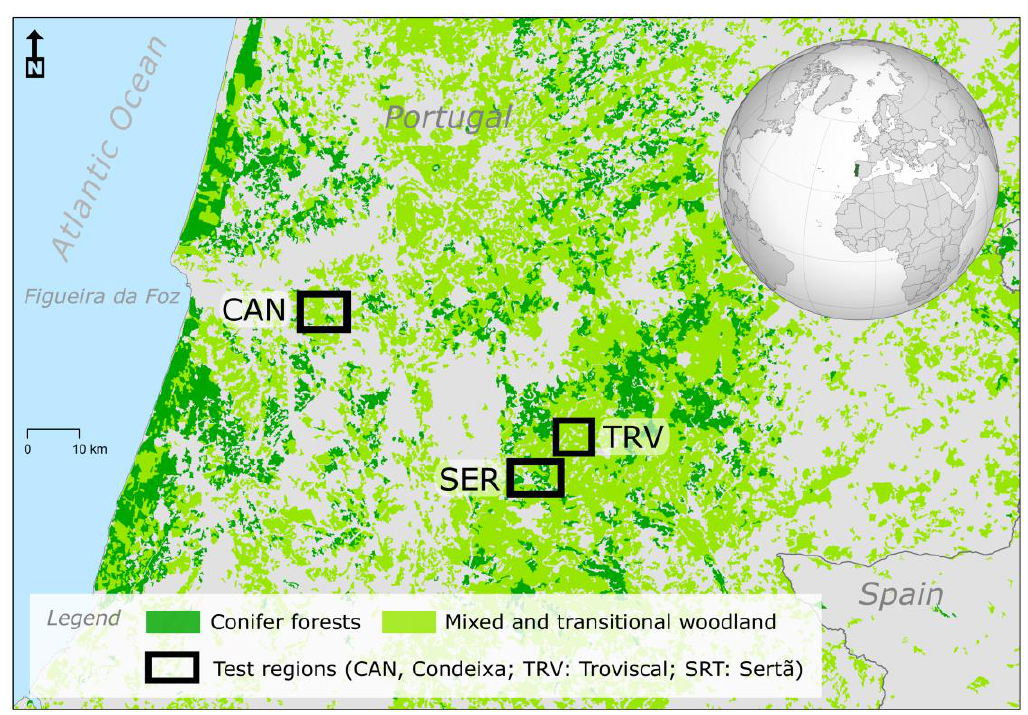
Figure 1. Location of the test regions (Troviscal (TRV), Sertã (SER), and Condeixa-a-Nova (CAN)) overlaid to Corine land cover.